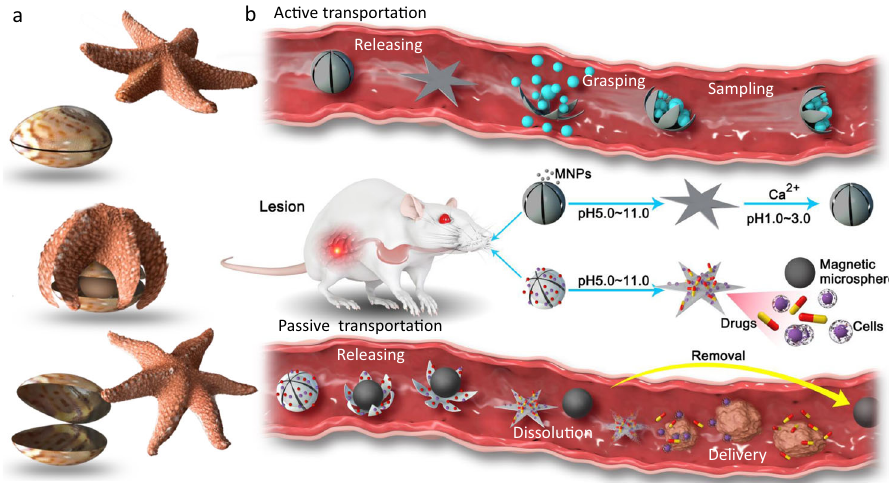
Fig. 1 Inspiration for the ISME. a A star fi sh moves to, preys on, then moves away from a conch. b Schematic illustration of an ISME in the gastrointestinal tract. Under active transportation, the ISME releases a payload and conducts target sampling under enteric pH or ionic stimulus. Under passive transportation, the ISME releases a payload and dissolves under pH 5 – 11, allowing ef fi cient delivery of drugs or cells to the